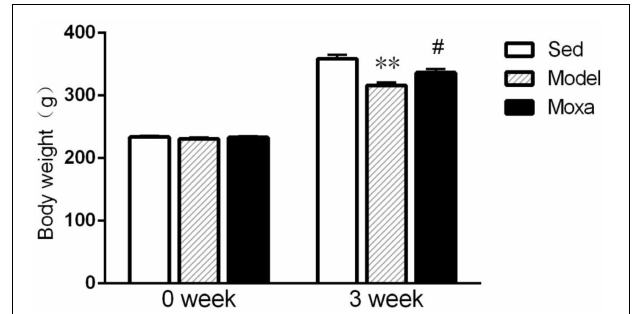
FIGURE 1 | Body weight in the following groups ( N = 8 per group): Sedentary (Sed), Model, Moxibustion (Moxa). Data are means ± SEM. ∗∗ P < 0.01 as compared with the Sed group, # P < 0.05 as compared with the Model group.